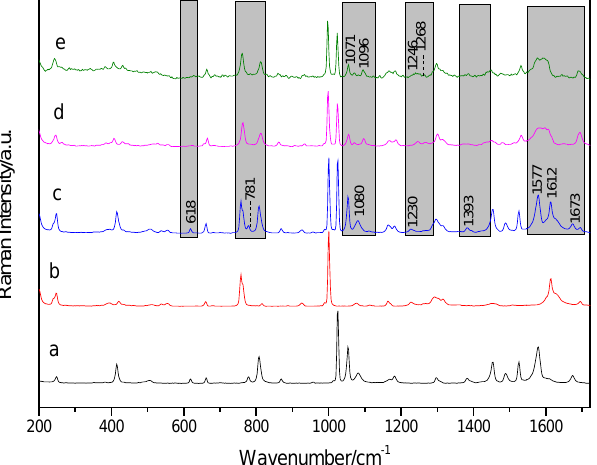
Figure 5. Raman spectra of PZA ( a ); 3-hBA ( b ); physical mixture ( c ); their solvent cocrystal ( d ); and grinding cocrystal ( e ).